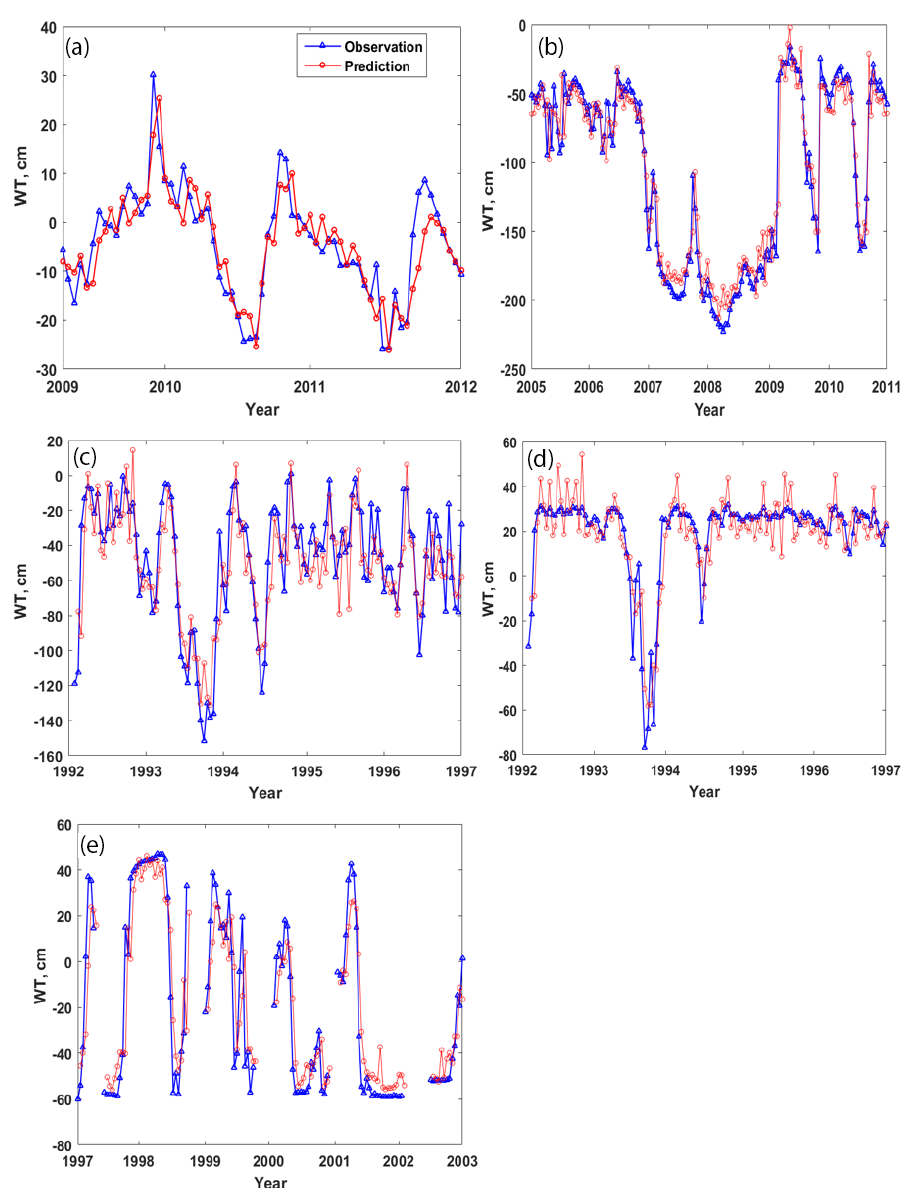
Figure 2. Comparison of observed and simulated mean water tables in five wetlands in the SE United States, where WT is the water table, (a) is site AR (Alligator River National Wildlife Refuge in North Carolina), (b) is site LP (loblolly pine plantation in North Carolina), (c) is site FL–UP (upland in Florida), (d) is site FL–WET (wetland in Florida), and (e) is site SC (wetland in South